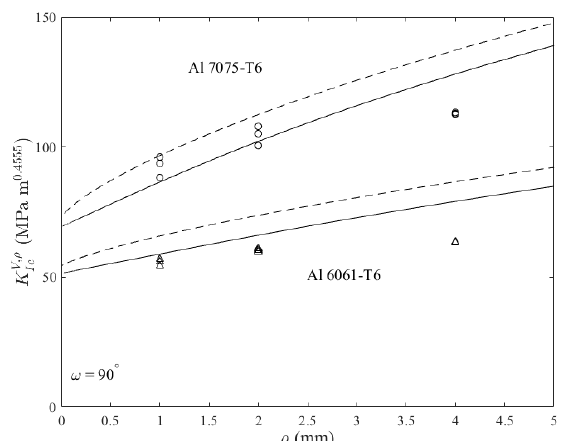
Figure 5. Blunt V-notched structures ( ω = 90 ◦ ), apparent generalized fracture toughness: Predictions by punctual FFM (dashed line) and average FFM (continuous line) related to experimental data on Al 7075-T6 plates (circles) and on Al 6061-T6 plates (triangles).